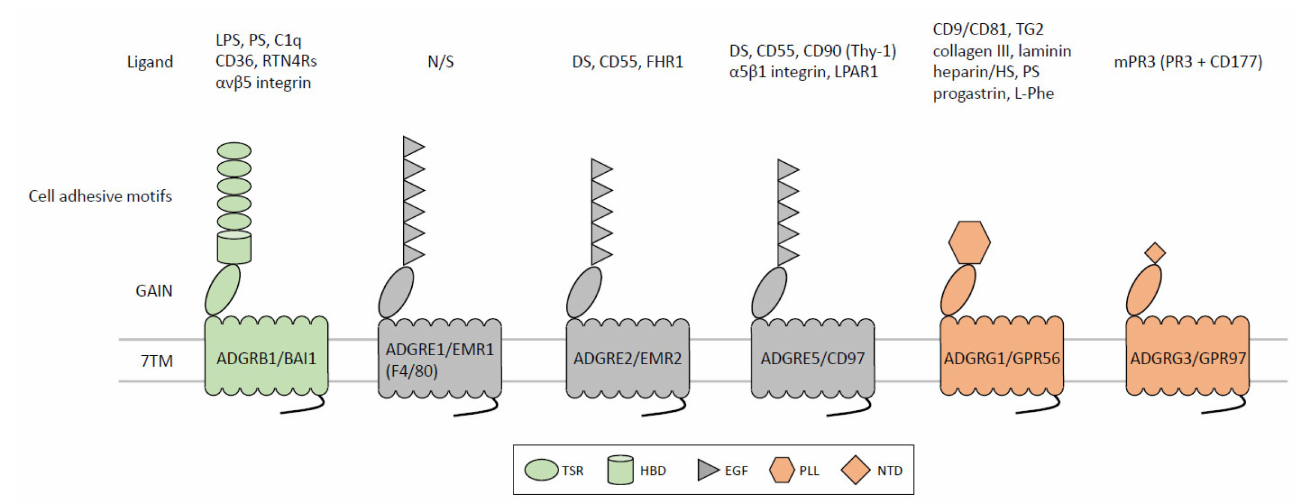
Figure 2. Molecular and functional characteristics of immune aGPCRs. The diagram shown is selective aGPCRs involved in immune dysfunctions. Different colored shapes in the N-terminal region represent various cell-adhesive protein motifs (detailed description in the lower panel). The GAIN domain is represented by a tilted oval. Ligands/interacting partners of each immune aGPCR are shown at the top panel. Abbreviations: C1q, complement component 1q; DS, dermatan sulfate; EGF, epidermal growth factor-like; FHR1, factor H-related protein 1; HBD, hormone-binding domain; HS, heparin sulfate; LPAR1, lysophosphatidic acid receptor 1; LPS, lipopolysaccharide; NTD, N-terminal domain; PLL, pentraxin/laminin/neurexin sex-hormone-binding globulin-like; PR3, proteinase 3; PS, phosphatidylserine; RTN4Rs, Reticulon-4 receptors; TG2, transglutaminase-2; TSR, thrombospondin type 1